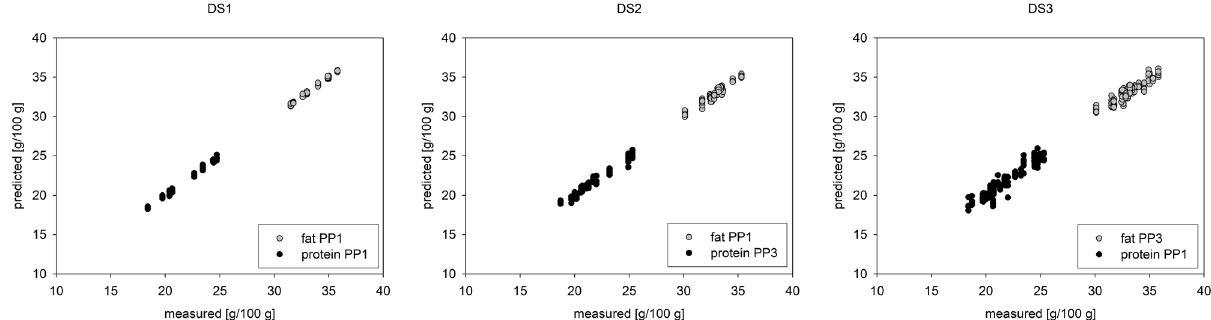
Figure 4. Prediction of fat and protein contents from not and pre-processed spectra of fluorescence (point 1–120) and NIR (121 up)